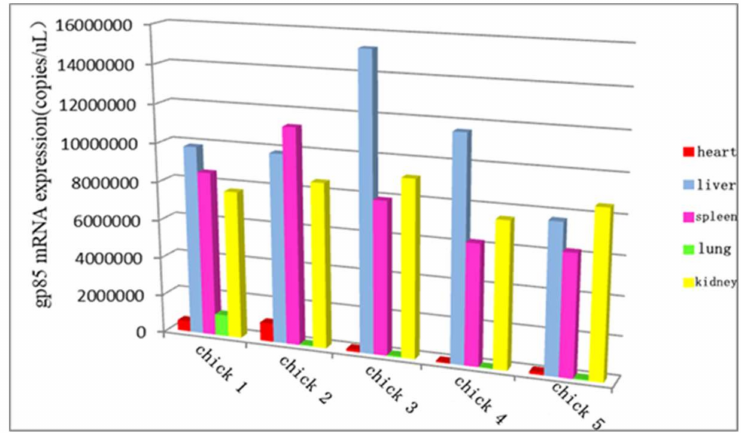
Figure 10. Real-time PCR method to investigate the distribution of ALV-K in different organs at the later stage of